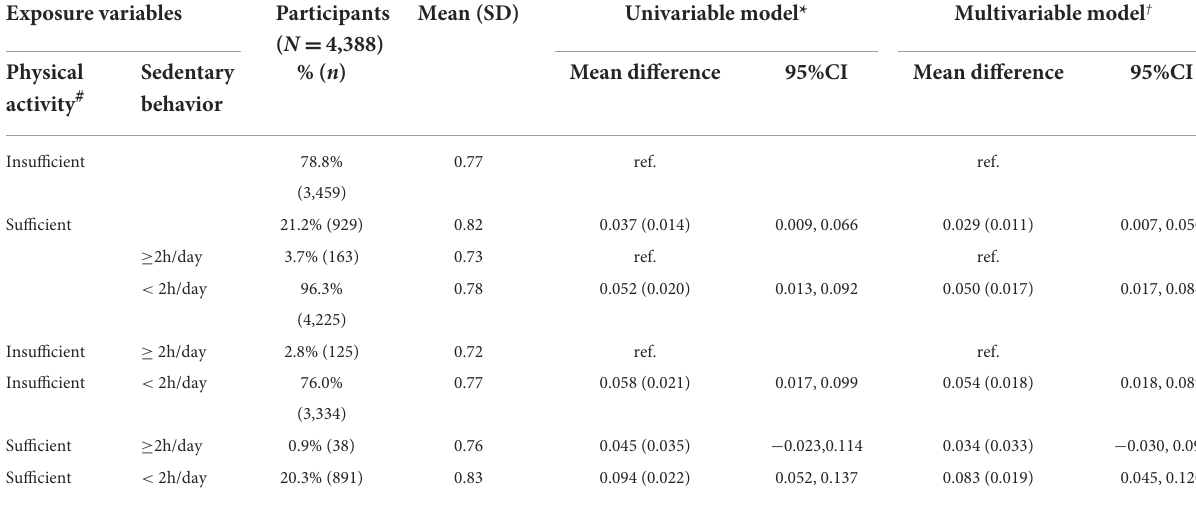
TABLE 3 Joint association of physical activity and screen time with HRQoL score among overall participants in this study. Exposure